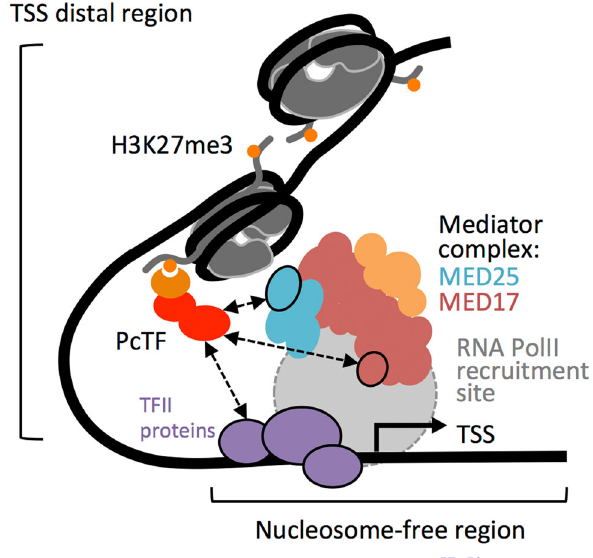
Fig. 7 Model for PcTF-mediated gene activation. 57,